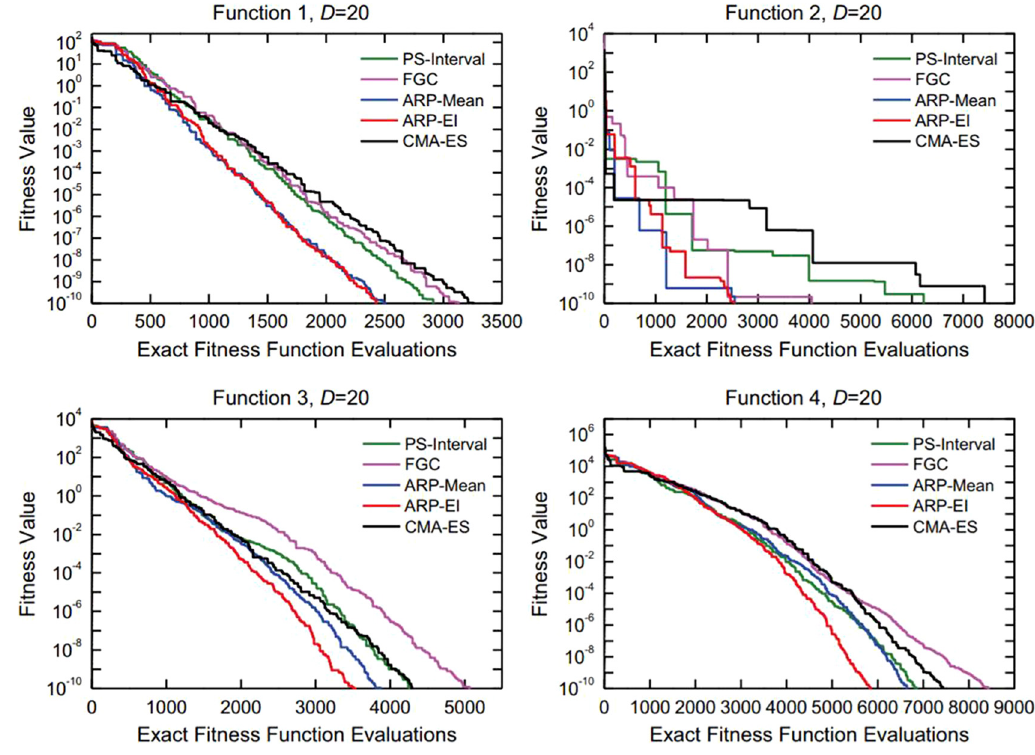
Fig. 1. Convergence graphs of f 1 – f 4 .